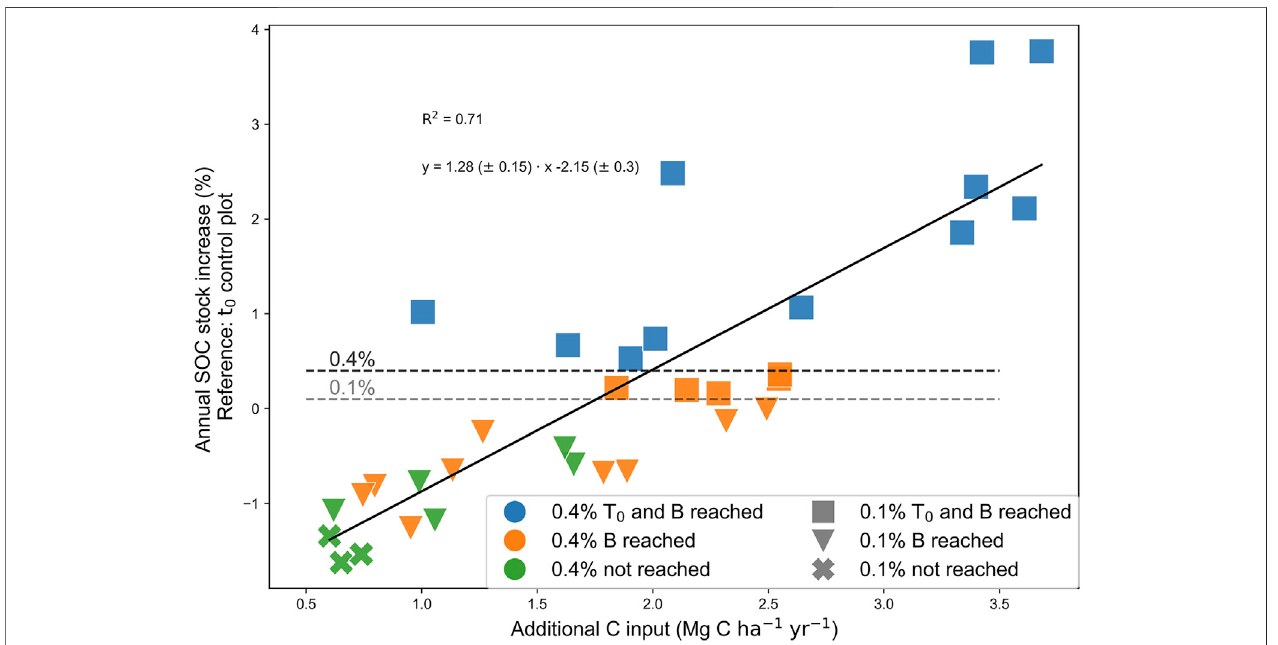
FIGURE2| Correlationbetweenannualsoilorganiccarbon(SOC)stockincrease(%)(at20 – 30 cmdepth)andadditionalcarbon(C)inputintheexogenousorganic matter (EOM) treatments (Mg C ha − 1 yr − 1 ). Different colors indicate whether the 0.4% SOC stock increase target was reached, based on the different approaches used to calculate the target (blue indicates that both 0.4% T 0 and 0.4% B targets were reached, orange indicates that 0.4% B was reached and green indicates that no 0.4% target was reached). Different symbols indicate whether the 0.1% SOC stock increase target was reached, based on the different approaches used (squares indicatethatboth 0.1%T 0 and 0.1%Btargetswerereached,inverse triangles indicatethat0.1%Bwasreachedand crossesindicatethatnotargetwasreached).SOC stock increase wascalculatedrelativetothe fi rstyear ofexperimentinthecontroltreatment.AdditionalCinputconsisted ofEOMinputs and additionalCfromincreased crop growth, relative to the control